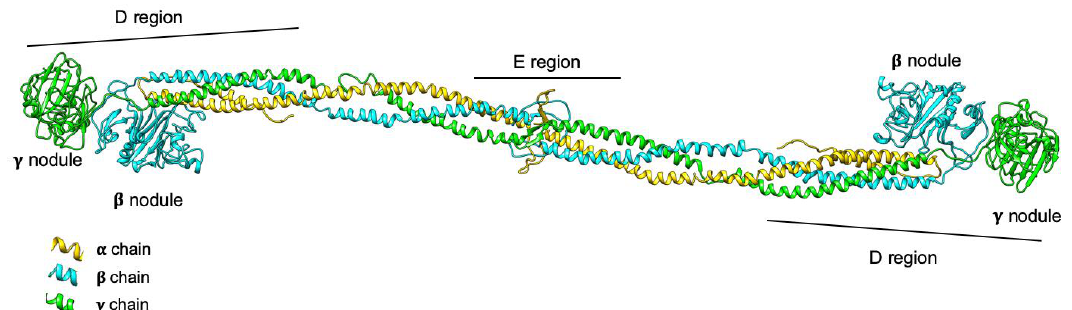
Figure 1. 3D model representation of the fibrinogen protein. The three fibrinogen chains (Aα, Bβ, and γ) are represented in yellow, cyan, and green, respectively; the domains composing the molecule are also shown. The D regions correspond to lateral globular parts containing the C-terminus of Bβ and γ chains; the E region is the central nodule, containing the N-terminus of all chains. The model was obtained using the pdb structure 3GHG and the UCSF Chimera